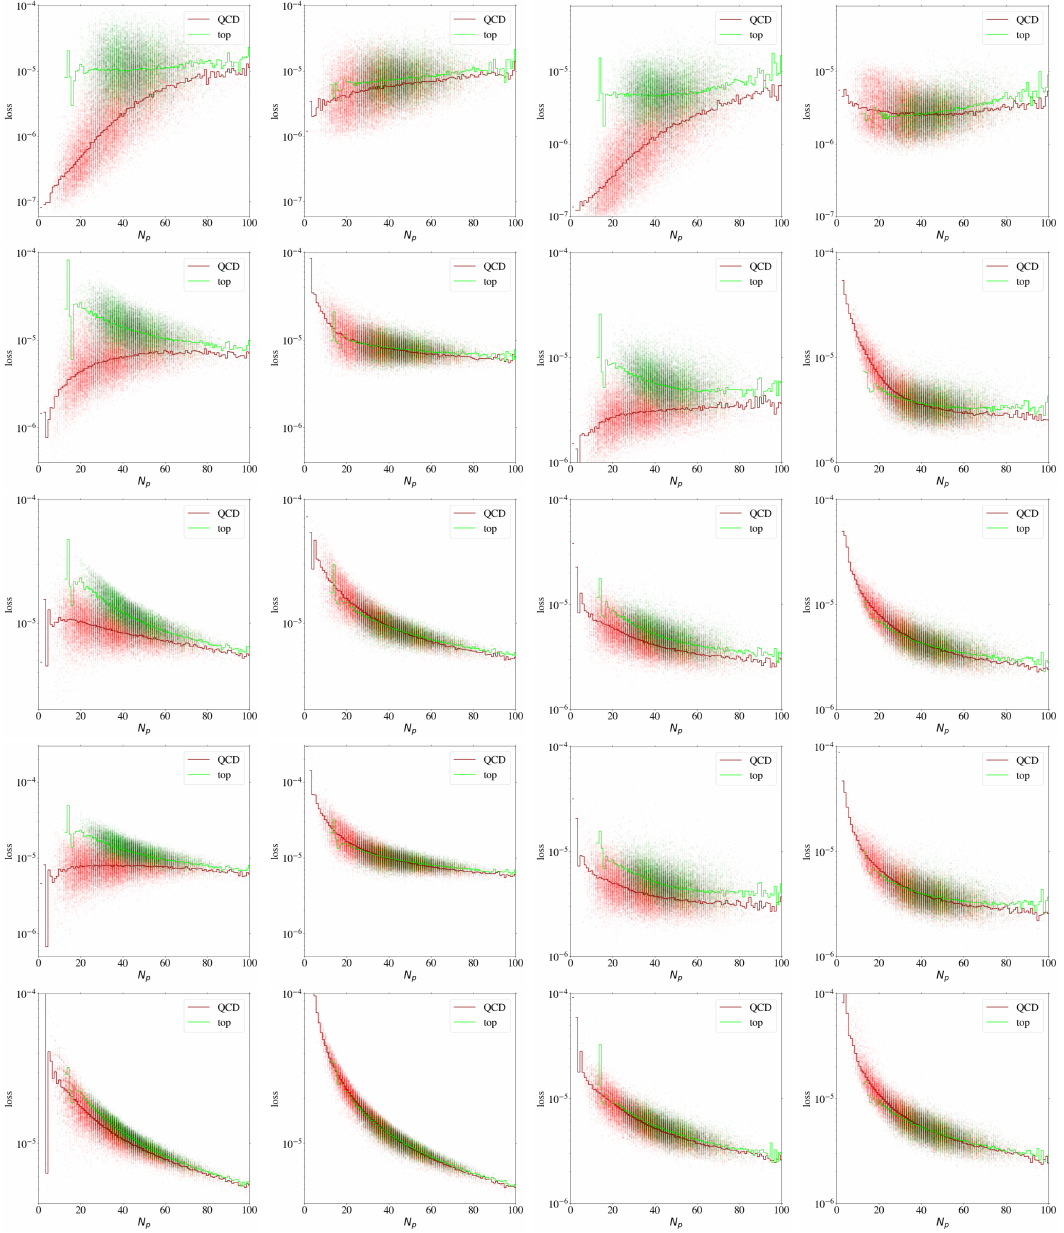
Figure 19 . Reconstruction loss of individual test jets as a function of the number of non-zero pixels N p , cf. figure 6. The first and second columns represent the results for an AE trained on QCD and top jet images, respectively, using MSE loss, while the third and fourth columns show the corresponding results using the KMSE loss function. The rows correspond to the different image remappings R 0 , R 1 , R 2 , R 3 and R 4 from top to